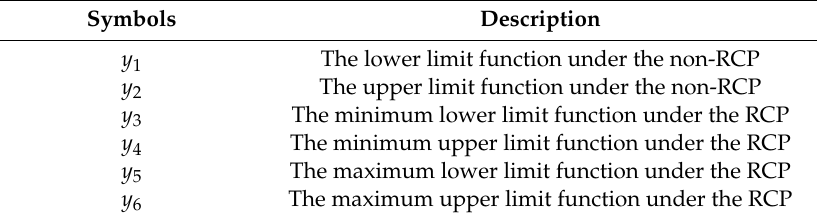
Table 1. The specifications of symbols used in this